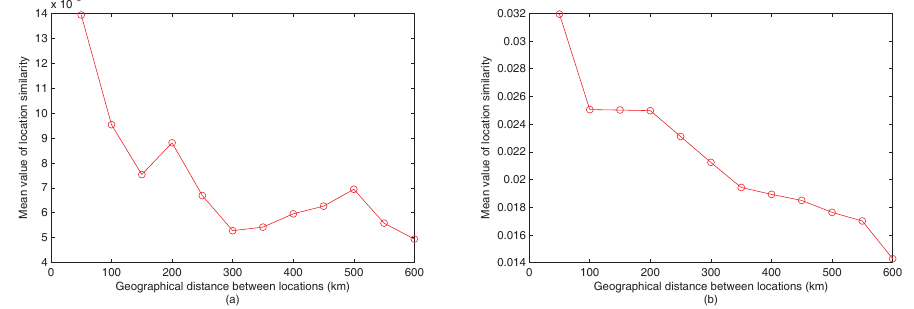
Figure 3. The variation trend of POI similarity with the increase of the geographical distance in two datasets: ( a ) Gowalla and ( b )